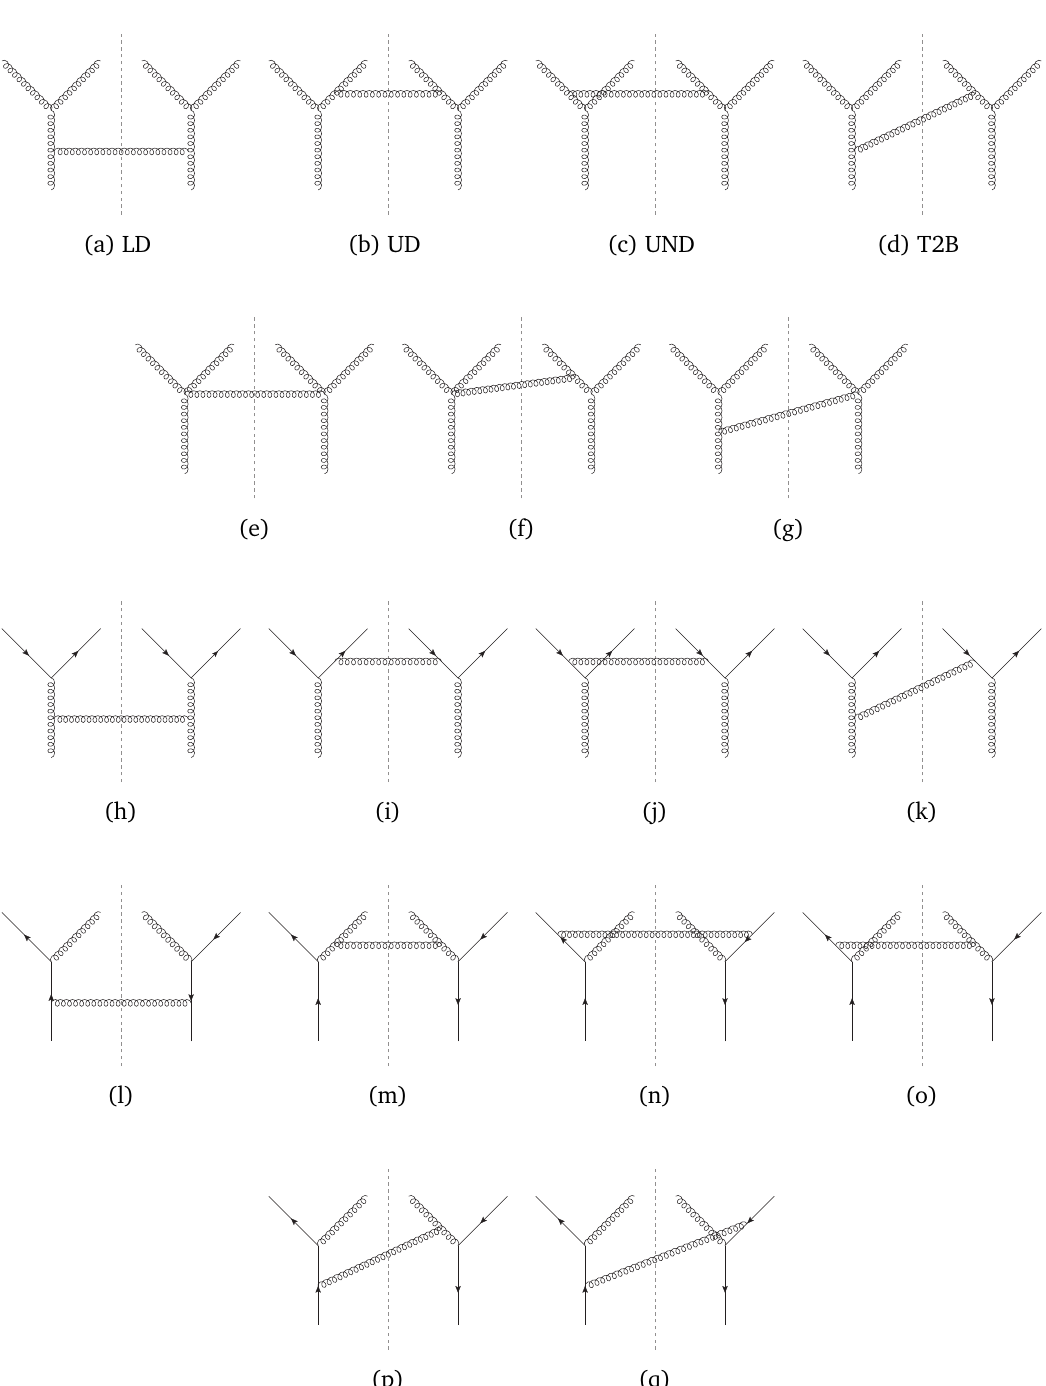
, a , a and a from left to right. The 1 2 2 1